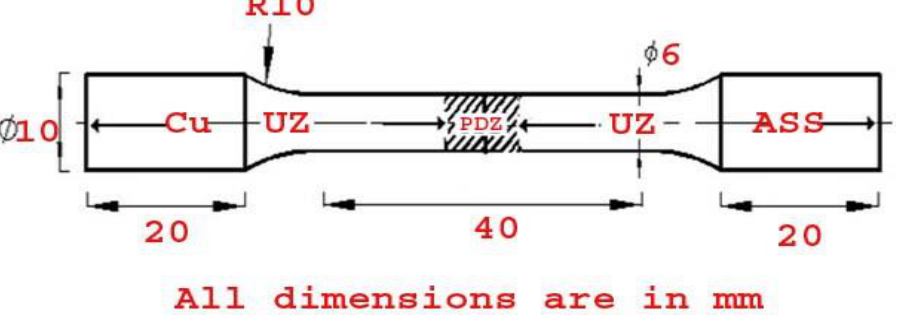
Figure 1. Dimensions of the Unnotched Tensile Specimen.